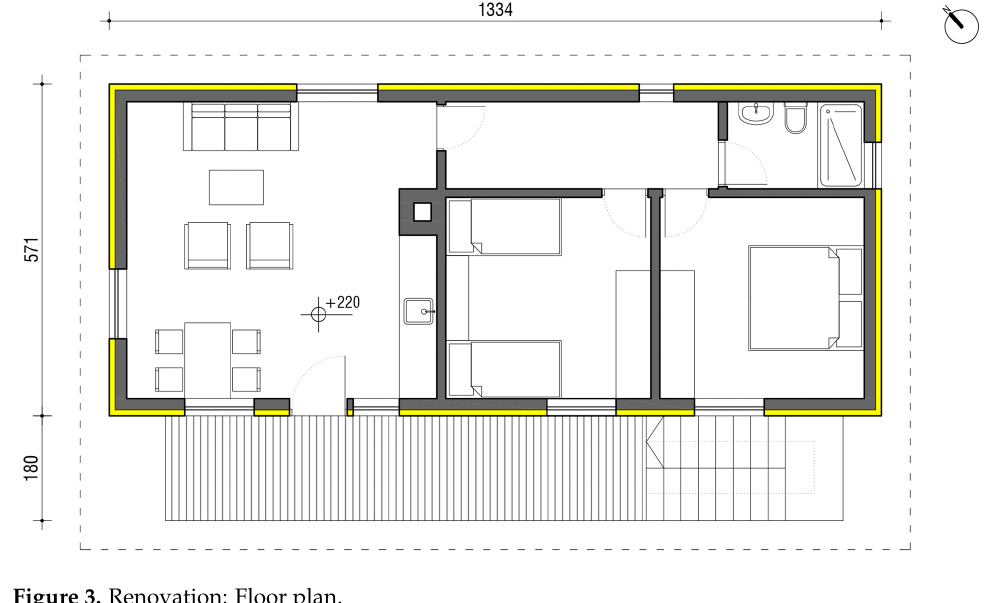
Figure 3. Renovation: Floor plan.